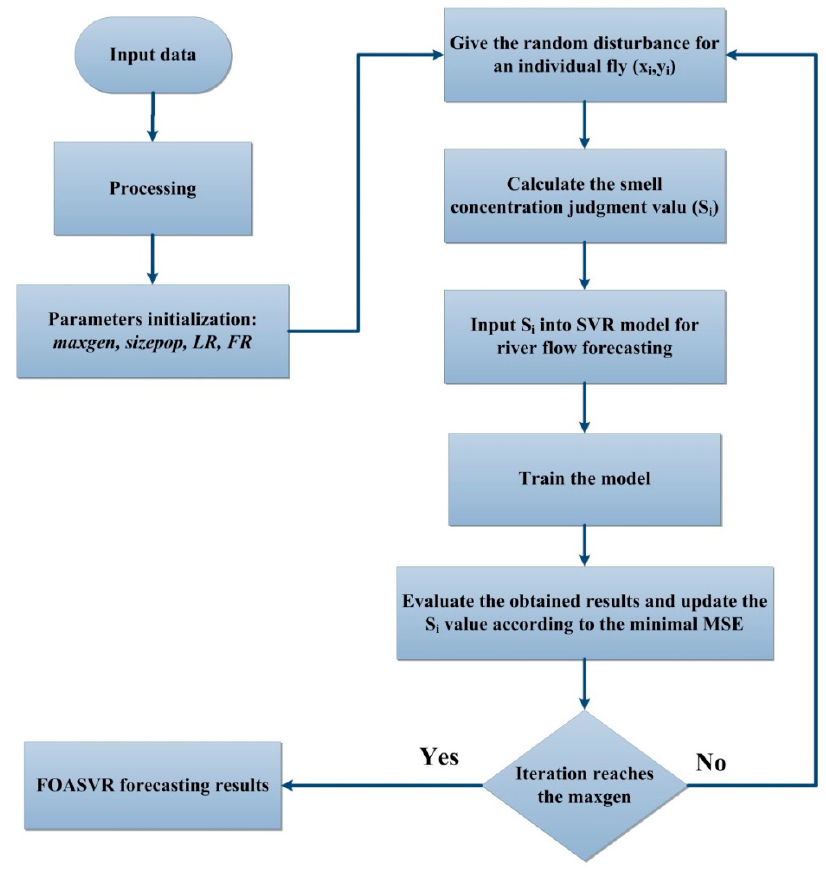
Figure 4. FOASVR Figure 4. FOASVR flowchart.